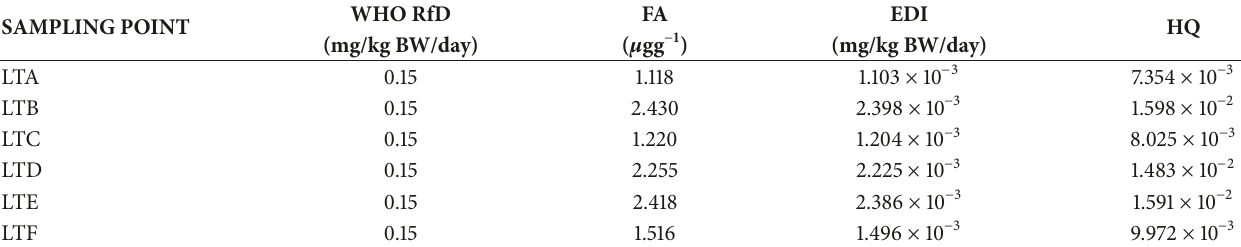
Table 6: The EDI results for carcinogenic risk evaluation expressed in mg/kg body weight/day for tilapia in cold stores. SAMPLING POINT